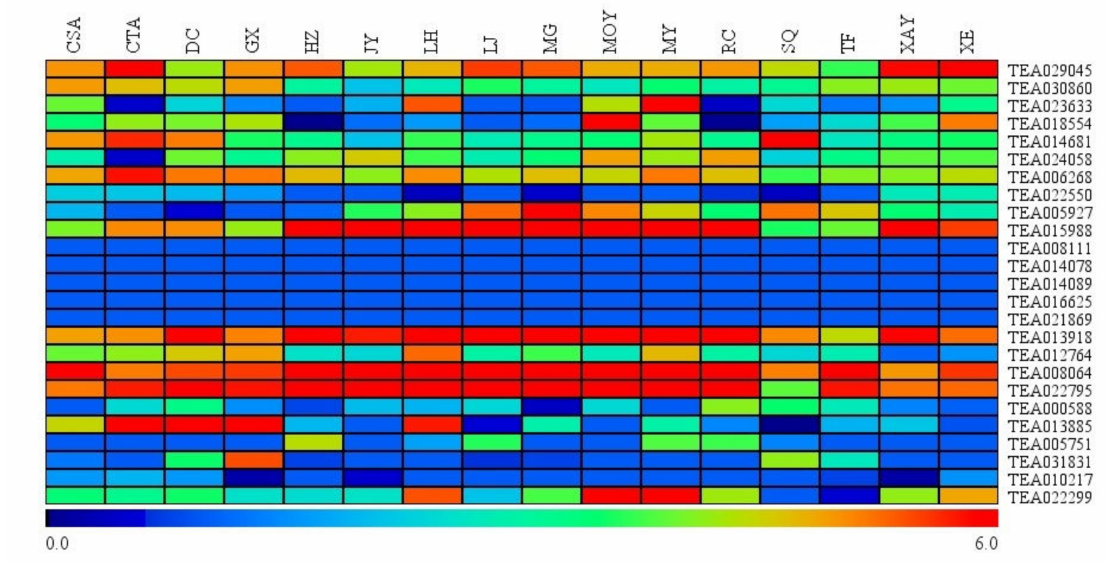
Figure 4. Expression patterns of Hsf genes in di ff erent Camellia species. The heatmap was generated by MeV software (TIGR, Rockville, MD, USA) using the Hsf genes’ expression data, and normalized log 2 transformed values were used with hierarchical clustering. The red and green colors indicate higher or lower transcript abundances than those of the relevant control,